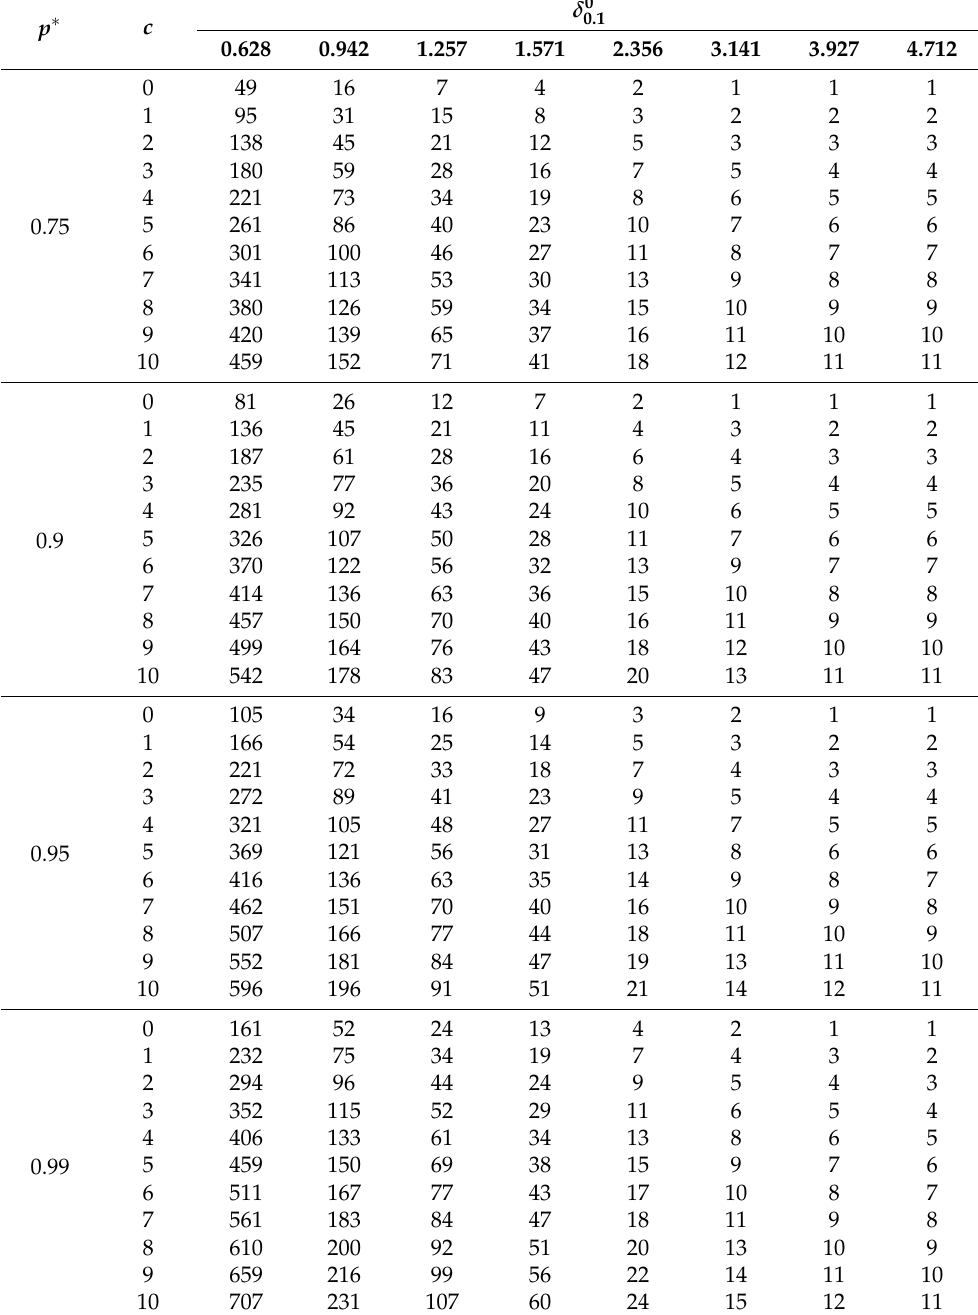
t q as a function of d q = can be calculated for the sampling plan t 0 q the model parameter values. Table 3 is devoted to the OC values for the sampling plan (cid:0) (cid:1) n , c = 2, t / t 0 when η = 2.793 and α = 1.011 for the NWPD, and in Table 4 for η = 2 0.1 and α = 2. Table 1. Minimum sample sizes necessary to assure the percentile q = 0.1 life of a product to exceed a given t 0 with η = 2.793 and α = 1.011 for the 0.1